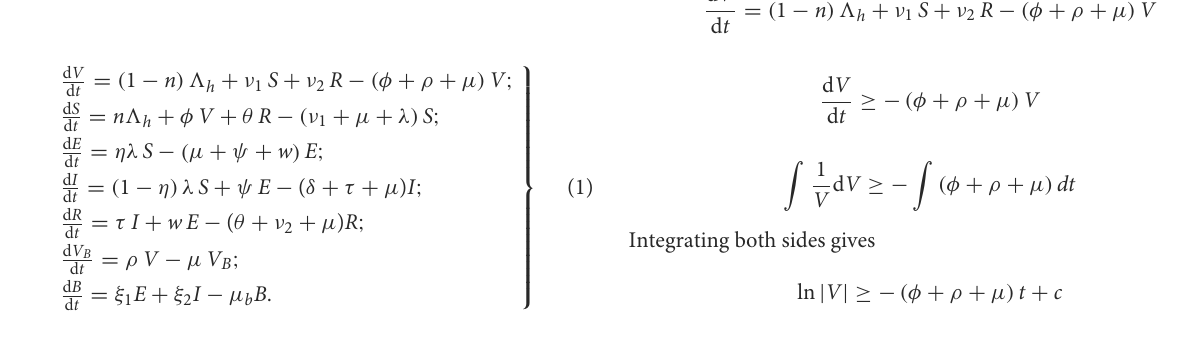
progression of exposed individuals into the infected class at rate ψ . The infected population diminishes in the following manner: a successful treatment at rate τ , a disease-induced mortality at rate of δ , and natural mortality rate of µ . The recovered compartment population increases through a successful treatment of infected persons at the rate of τ and natural self-recovery of the exposed at the rate of w . The recovered compartment also reduces as a result of temporal immunity loss at the rate θ , rate of vaccination ν 2 , and natural mortality rate µ . The booster vaccinated compartment grows through the intake of booster vaccine by the vaccinated compartment at the rate ρ and reduces as a result of the natural mortality rate µ and the Pathogen concentration increases through the shedding of pathogens by exposed and infectious persons at rates ξ 1 and ξ 2 , respectively. The decay rate of pathogens is taken to be µ b . The schematic diagram that represents the model described thus far is presented in Figure